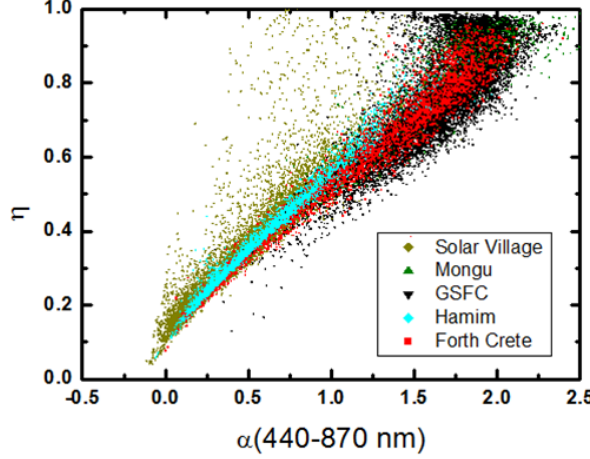
Figure 1. Fine mode fraction to aerosol optical depth ( η) as function of Ångström parameter ( α